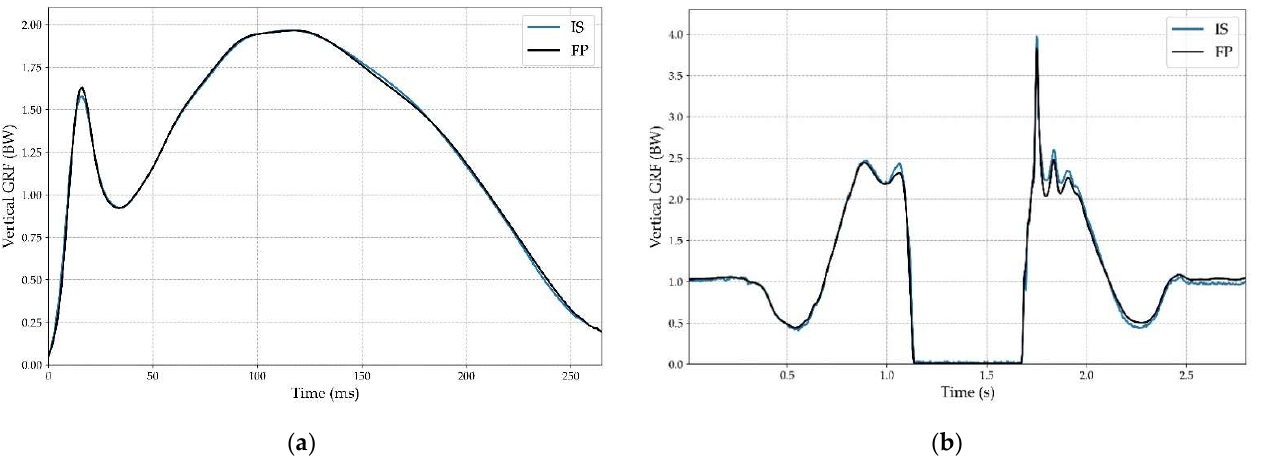
Figure 6. ( a ) Mean vertical ground reaction forces (GRF) vs. time curve computed for the 50 steps by the force platform (FP, black line) and mean normal ground reaction forces (nGRF) vs. time curve by the instrumented shoe (IS, blue line) for one subject; ( b ) Example of a vGRF and a nGRF curve from a CMJ (IS: blue line; FP: black line).